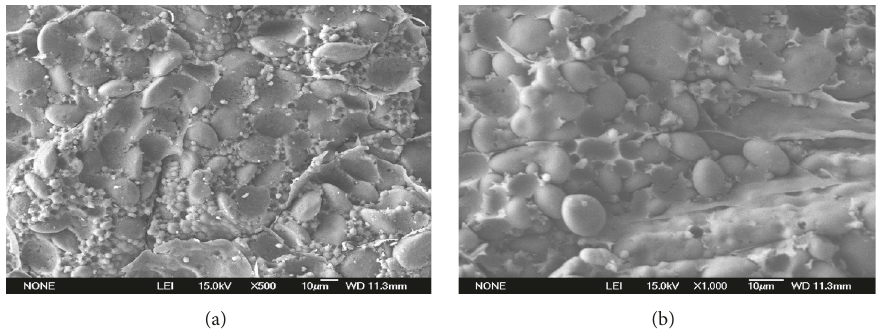
Figure 3: SEM of green and normal wheat endosperms. (a) GW3104 and (b) YN19.